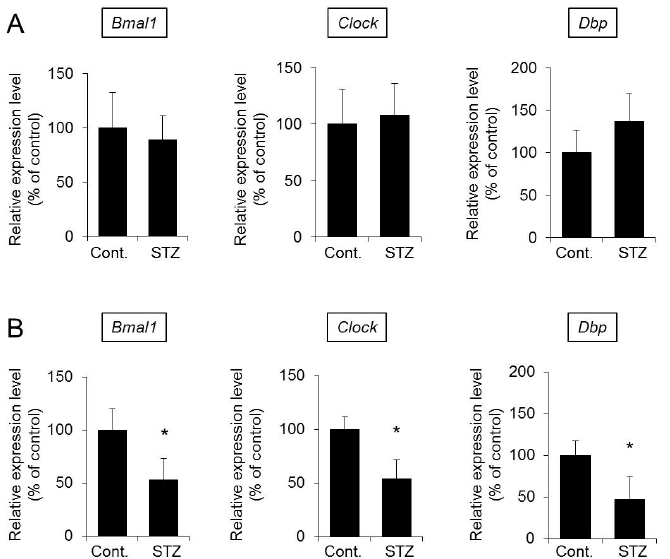
Figure 5. Expression levels of Bmal1 , Clock , and Dbp in the skin. Mice were given a single intravenous administration of STZ. After one week ( A ) or two weeks ( B ), the mRNA expression levels of Bmal1 , Clock , and Dbp in the skin were measured by real-time RT-PCR. After normalization with 18S rRNA , the data are presented with the mean value of the control group set at 100% (mean ± SD, n = 5, * p < 0.05).